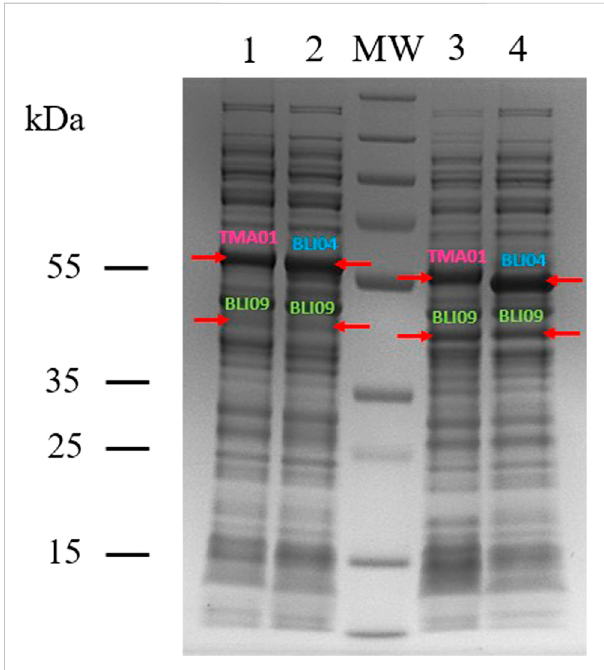
FIGURE 2 SDS-PAGE showing the co-expression of BLI09 PME with either TMA01orBLI04exo-PGsinpETDuet-1and E.coli BL21(DE3).Lanes:1, co-expressionconstruct1(pETDuet-BLI09-TMA01);2,co-expression